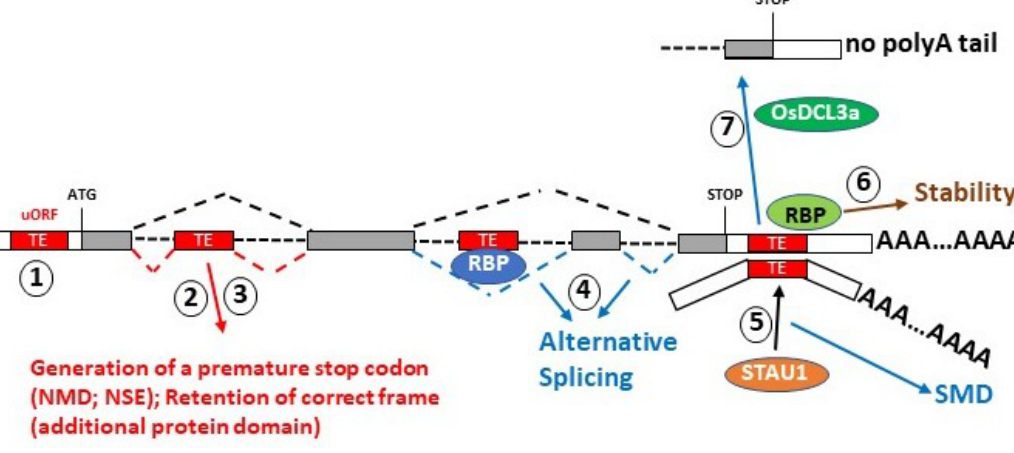
Figure 2. TE-dependent post-transcriptional regulation of gene expression . (1) TE inside the 5′-UTR cause the presence of an upstream ORF that participates in the regulation of the main ORF